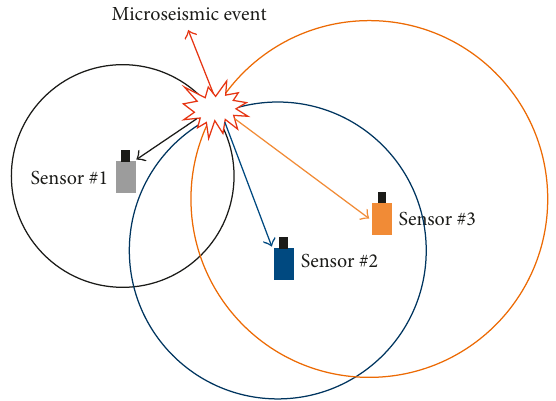
Figure 1: Schematic diagram of the positioning principle for microseismic